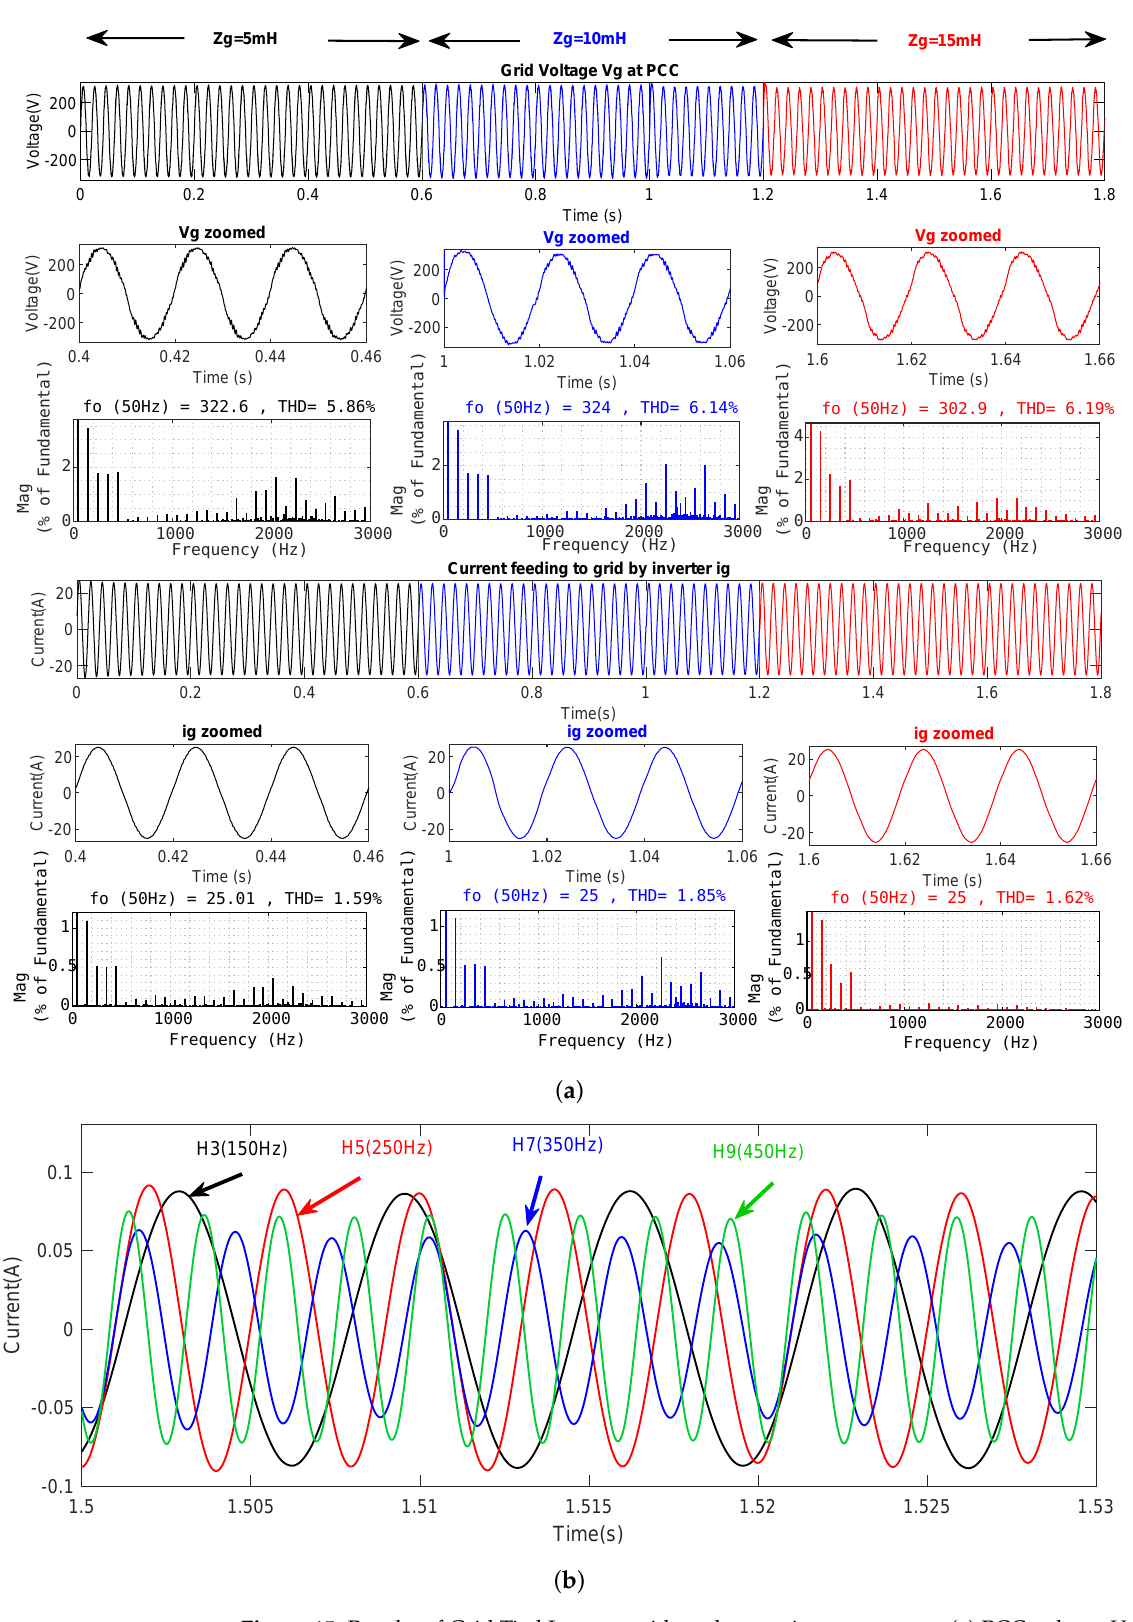
Figure 15. Results of Grid Tied Inverter without harmonic compensator. ( a ) PCC voltage V g and grid current i g along with their respective FFT analysis. ( b ) First four odd harmonics in current i g when grid impedance Z g ( s ) is 15